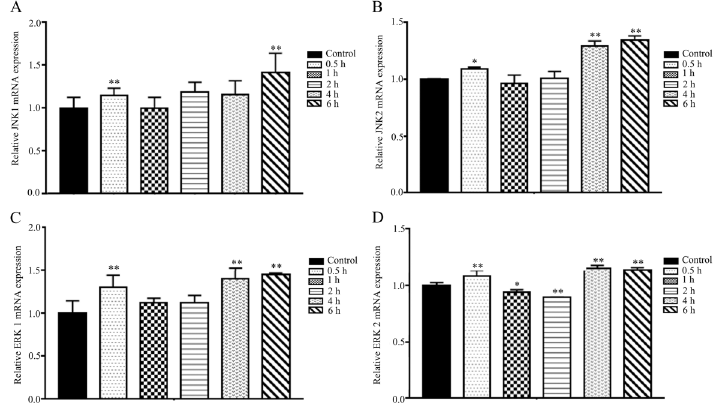
Figure 6. Effect of Tan I on the mRNA expression levels of JNK1/2 and ERK1/2 at different treatment times. A – D , The mRNA expression changes of JNK1/2 and ERK1/2 were determined by quantitative PCR analysis after exposure to Tan I. Data are reported as means ± SD. *P o 0.05, **P o 0.01 compared with the corresponding control group